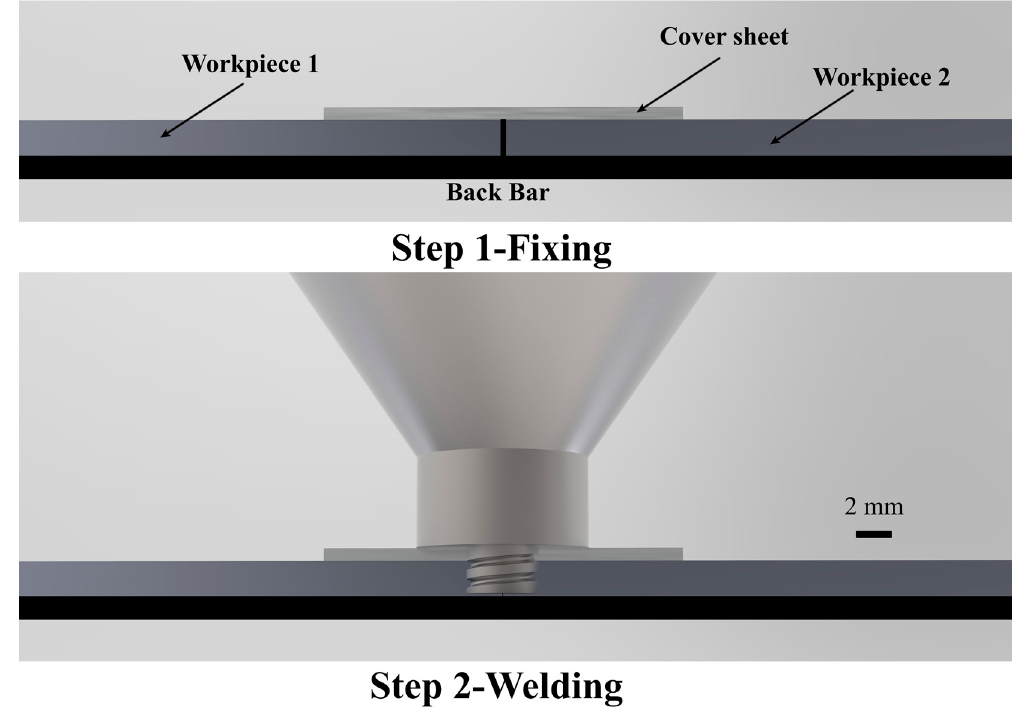
Figure 1. Sketch map of friction stir welding with cover sheet (CFSW).